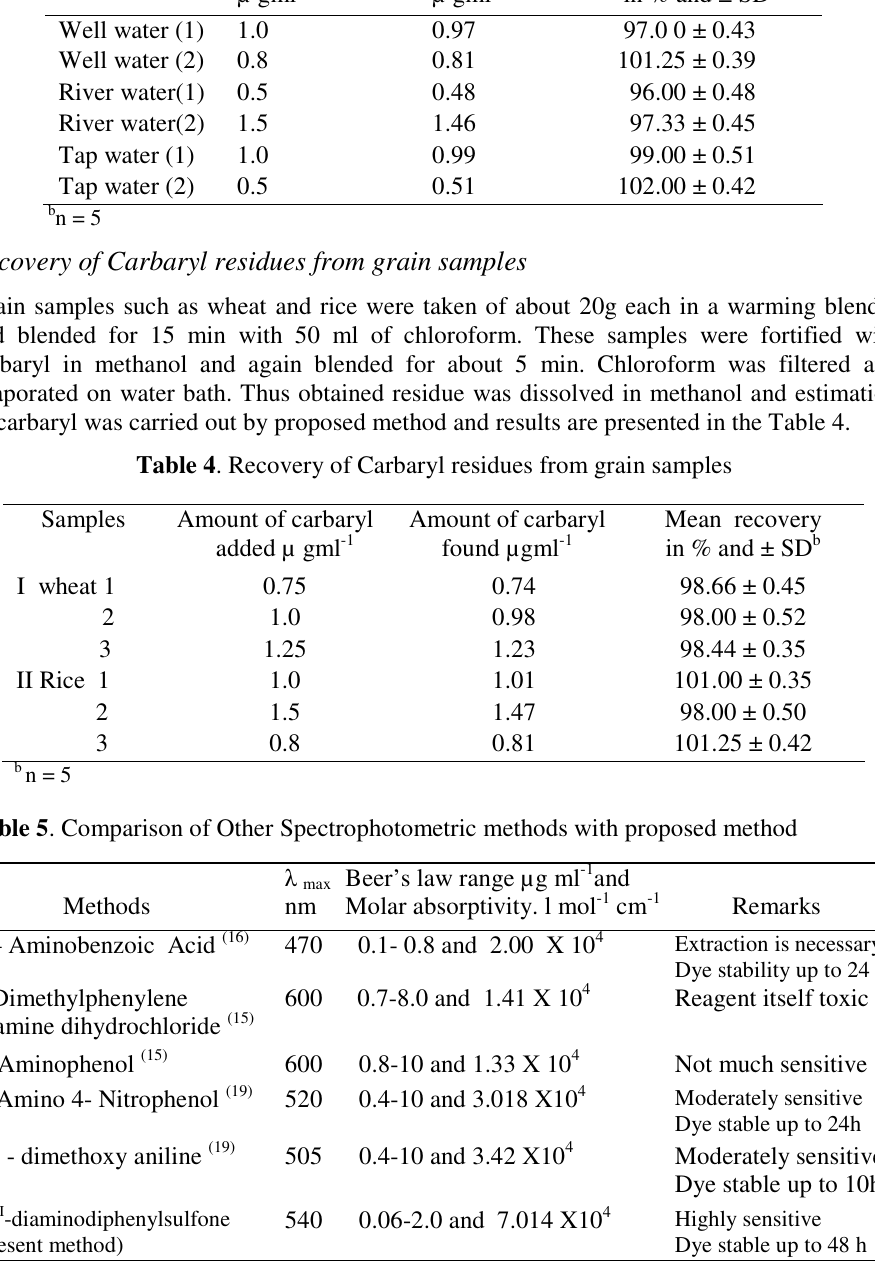
Table 3 . Recovery of carbaryl residue from spiked water samples Water sample